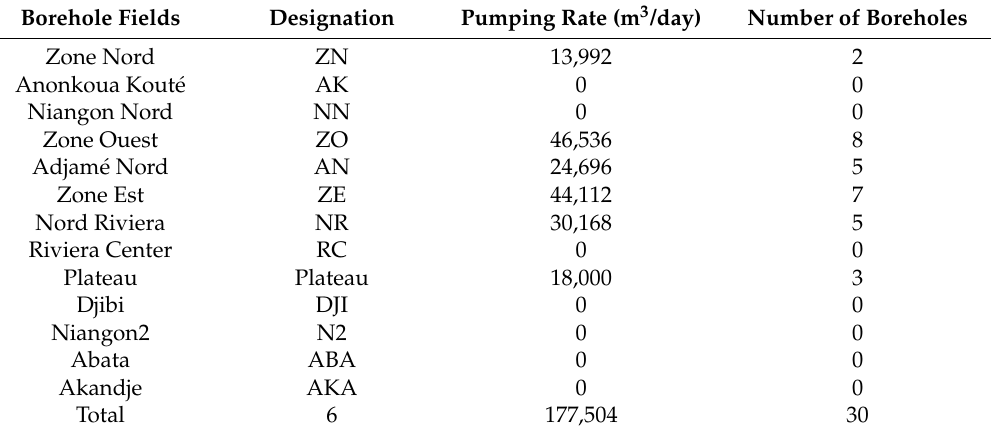
Table 1. Pumping rate in